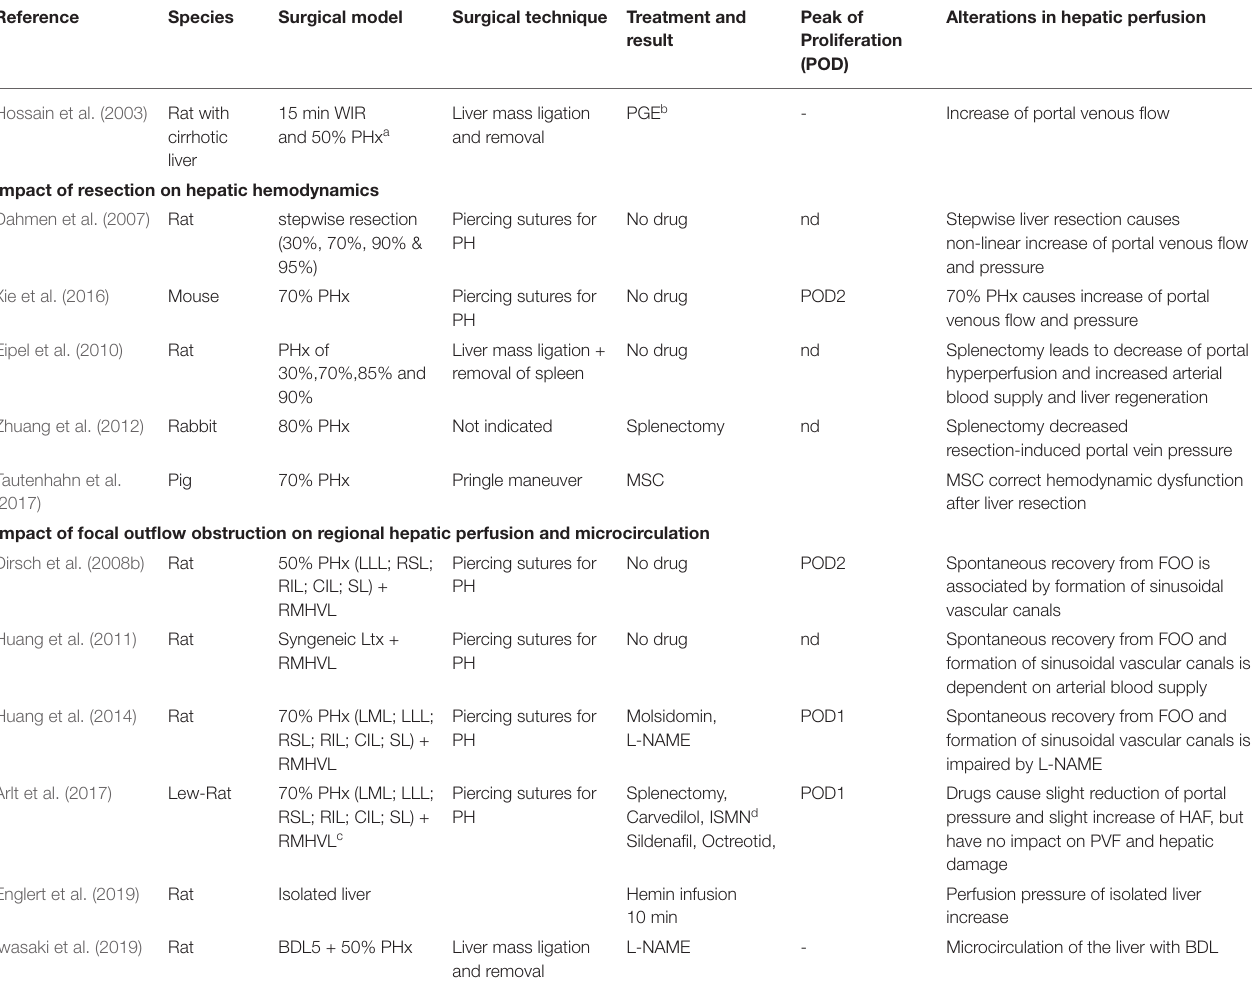
TABLE 5 | Rodent (liver resection) models impacting on hepatic perfusion (in the context of liver surgery).